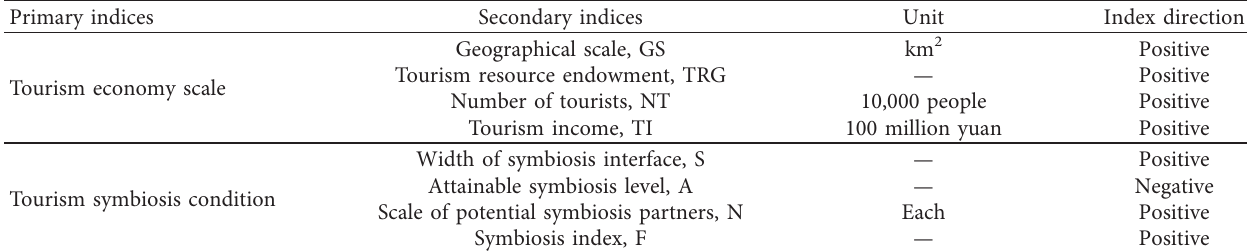
Table 1: Evaluation index system for the quality of tourism symbiosis